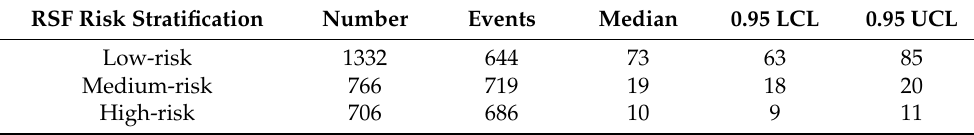
Table 3. The medium survival time (months) of different risk stratifications in the training set.